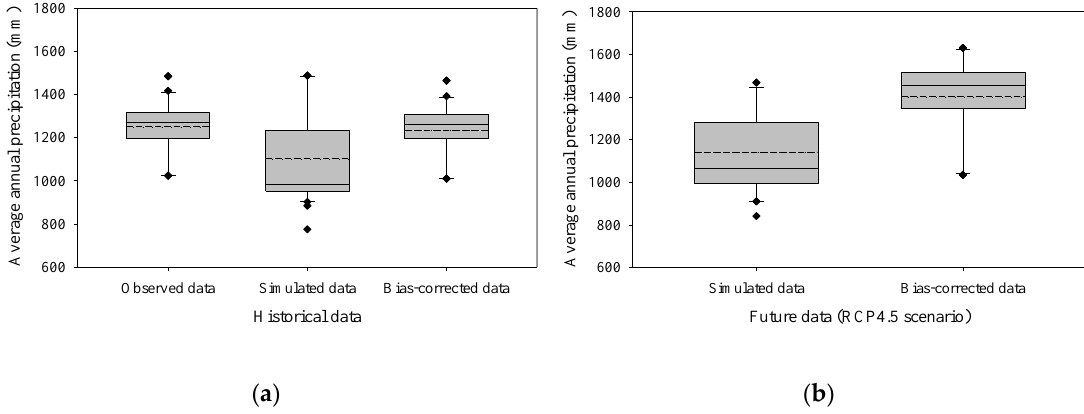
Figure 3. Bias-correction result of the past 30-year (1976–2005) and future 95-year (2006–2100) average annual precipitation for 30 agricultural reservoir watersheds. The dotted line is the average, whereas the solid line is the median. The diamond symbol is outliers. ( a ) past 30 years (1976–2005); ( b ) future 95 years (2006–2100).